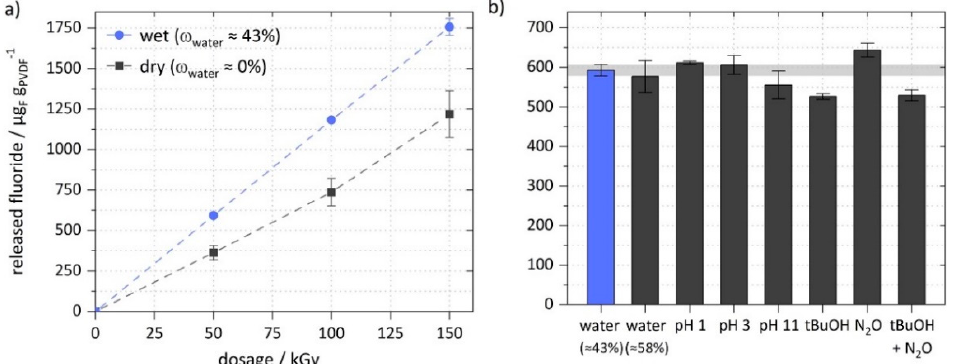
Figure 6. Amount of fluoride released after EB irradiation of PVDF, determined by ion